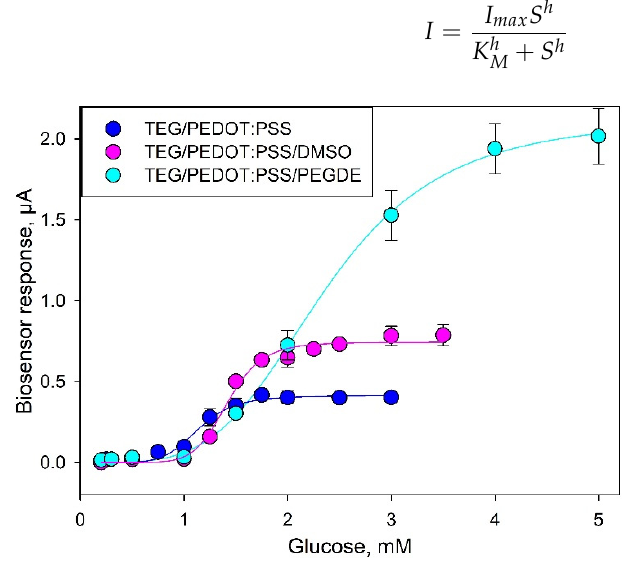
Figure 5. Calibration curves for glucose (values averaged from three consecutive